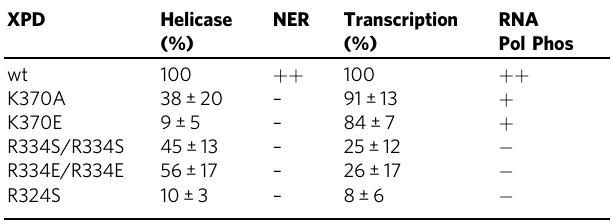
Raw data for Table 3 is provided as Supplementary Tables 2 and